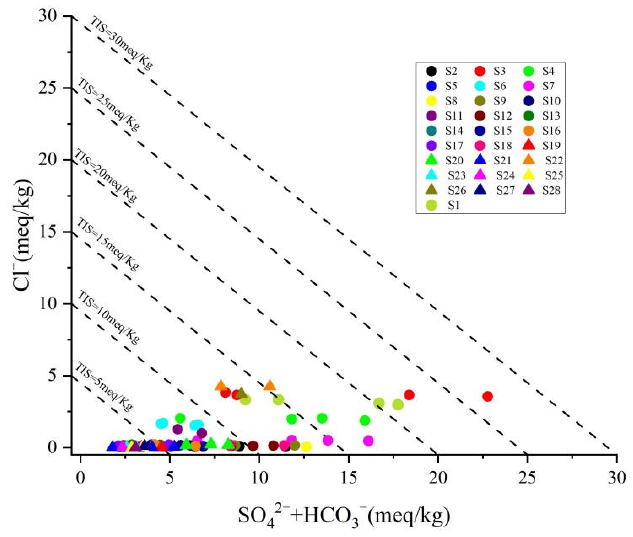
Figure 4. Correlation plot of SO 42 − + HCO 3 − vs. Cl − for the hot springs of the XJF, also showing isolines of total ionic salinity (TIS) lines for reference.